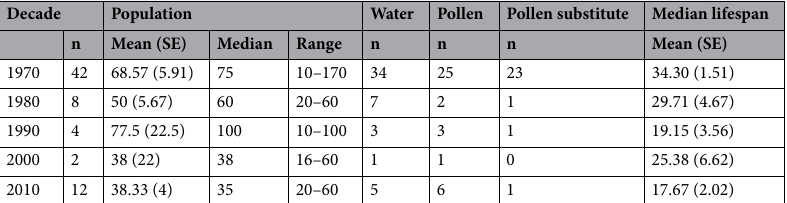
Table 1. Summary of experimental design variables and median lifespans by decade for all control groups of survivorship cage trials conducted in the US from 1970 to 2019.